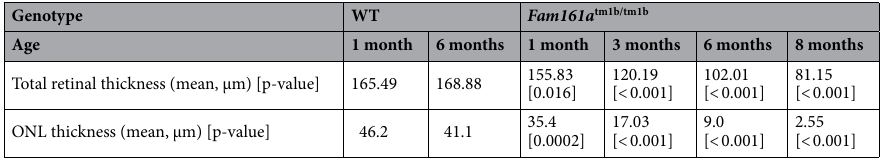
Table 1. Total retinal and outer nuclear layer (ONL) thickness in WT and Fam161a tm1b/tm1b mice.